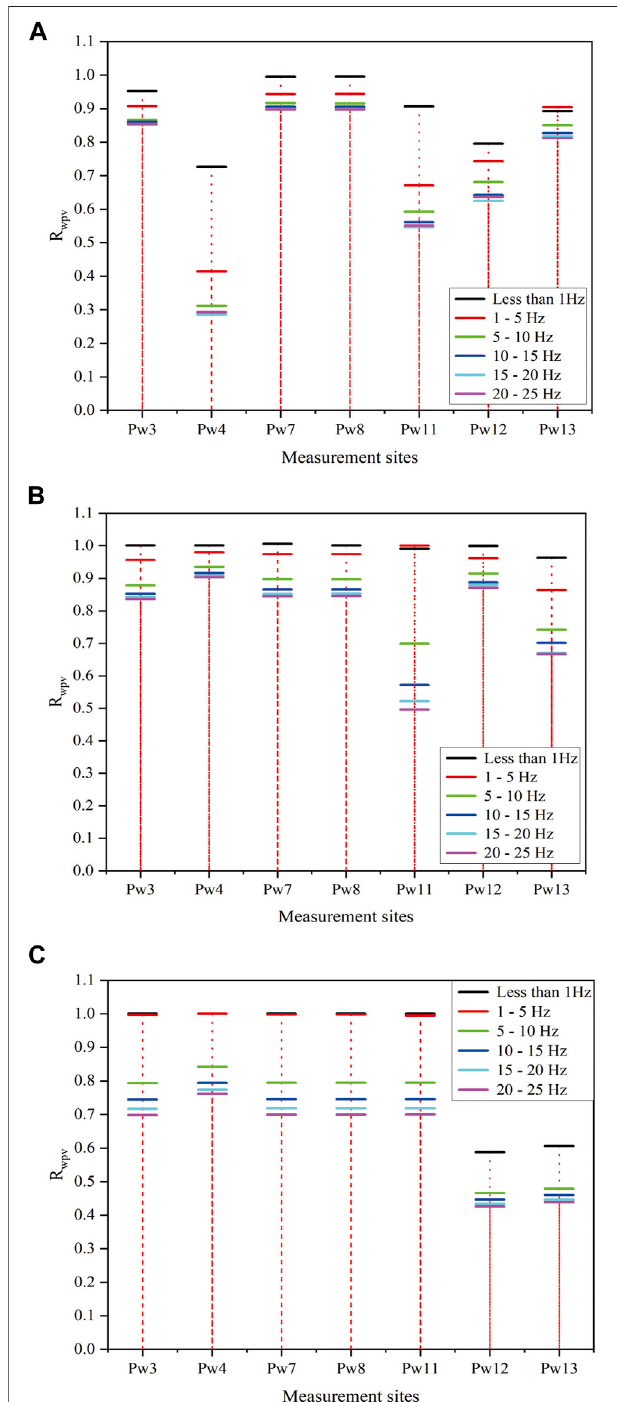
FIGURE11| Peakvalueratios( R WPV )betweentheporewaterpressures in six frequency bands (less than 1, 1 – 5, 5 – 10, 10 – 15, 15 – 20 and 20 – 25 Hz) and the corresponding total dynamic pore water pressures. (A) Low shaking intensity (case 1: 113 gal); (B) medium shaking intensity (case 3: 339 gal); (C) high shaking intensity (case 5: 565